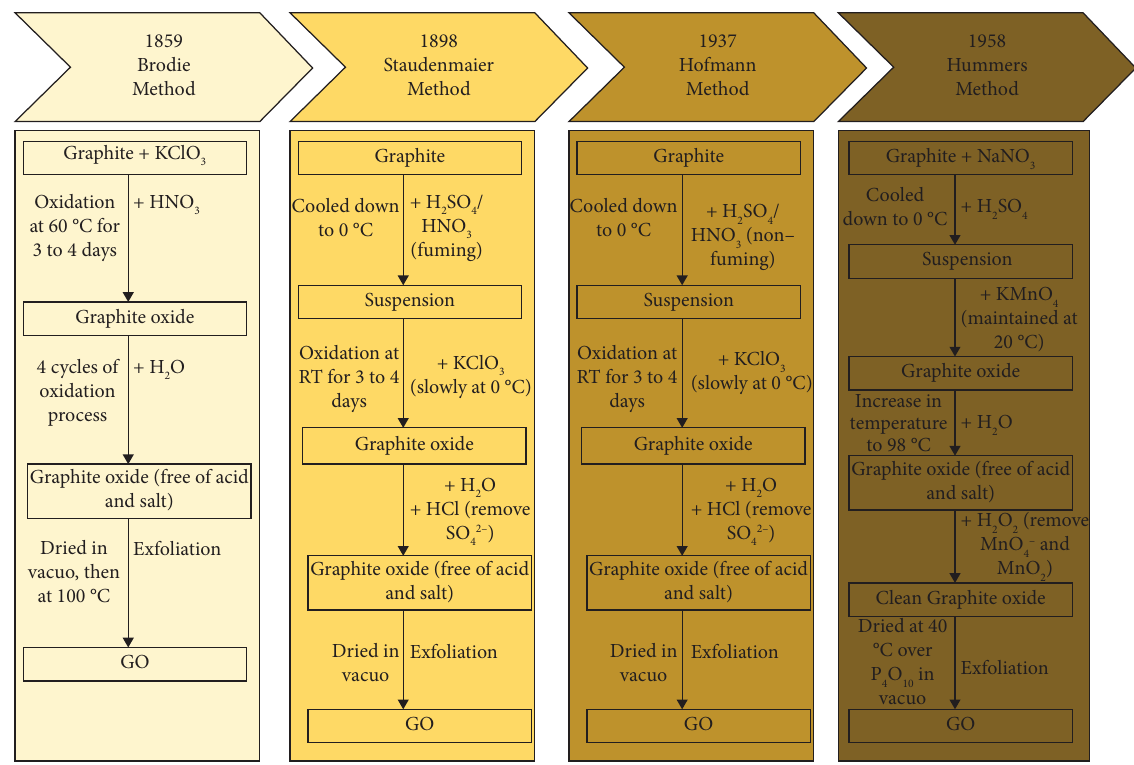
Figure 9: Methods of oxidizing graphene